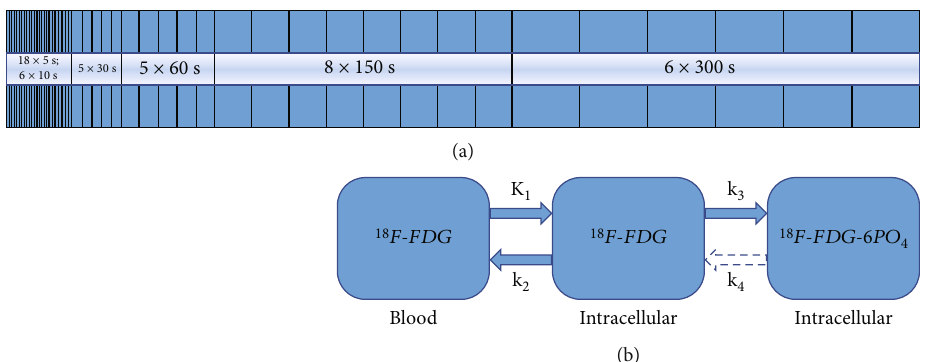
Figure 2: Dynamic acquisition mode and Patlak model. (a) Dynamic data were collected for 60min comprising 48 frames: 18 × 5 s , 6 × 10 s , 5 × 30s , 5 × 60 s , 8 × 150 s , and 6 × 300 s . (b) The Patlak plot has been developed for systems with irreversible trapping ( k is applied for the analysis of FDG. K between 18 F-FDG and 18 F-FDG-6PO rate constant, i.e., K i = K